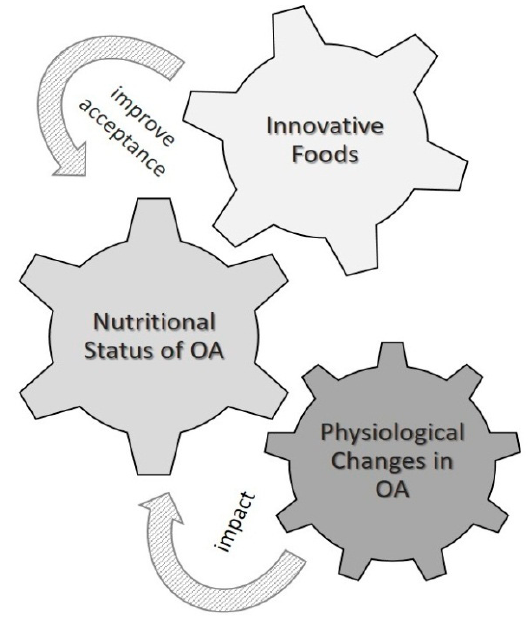
Figure 1. The physiological changes in older adults (OA) impact their nutritional status. Innovative foods with high acceptability must be developed to improve their nutritional status.